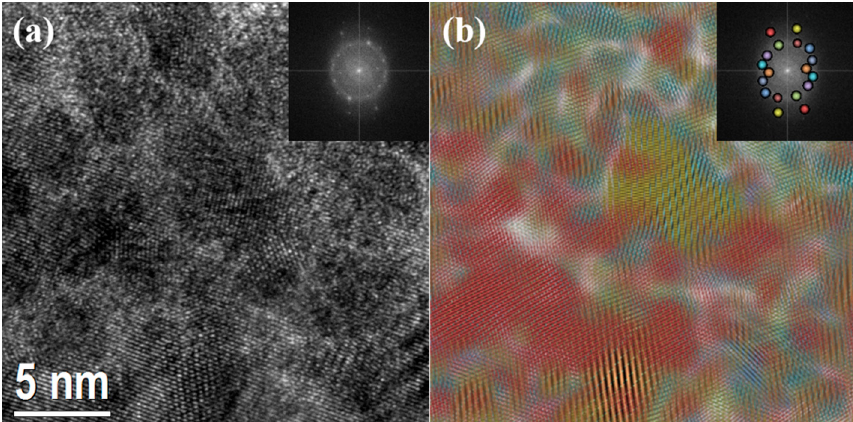
Figure 7. ( a ) HRTEM image and ( b ) the corresponding orientation distribution of ferrite in the deformed steel that was thermally aged at 400 °C for 20,000 h.